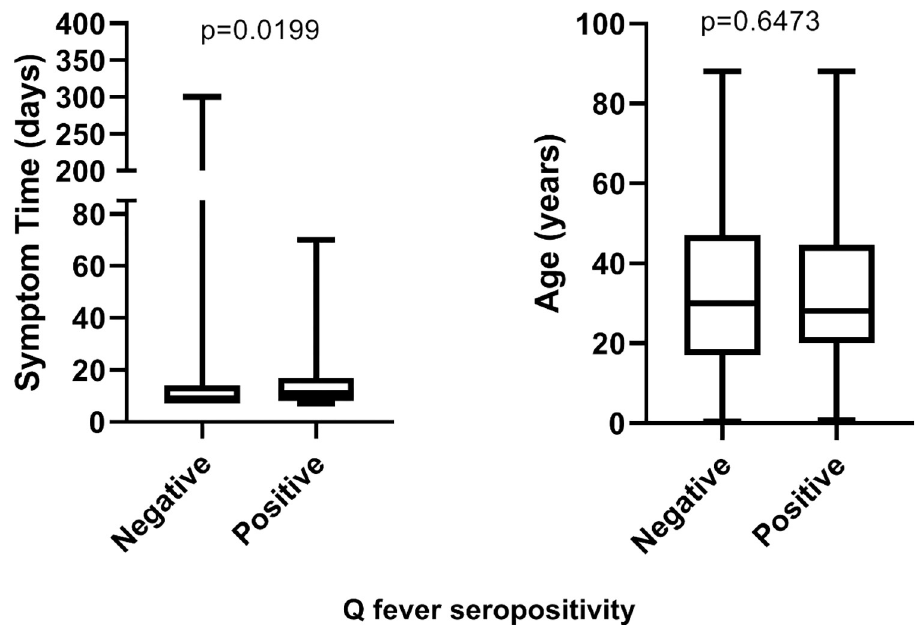
Fig 2. Distribution of symptom time (days) and age (years) by positivity for Q fever. P-values lower than 0.05 were considered statistically different.